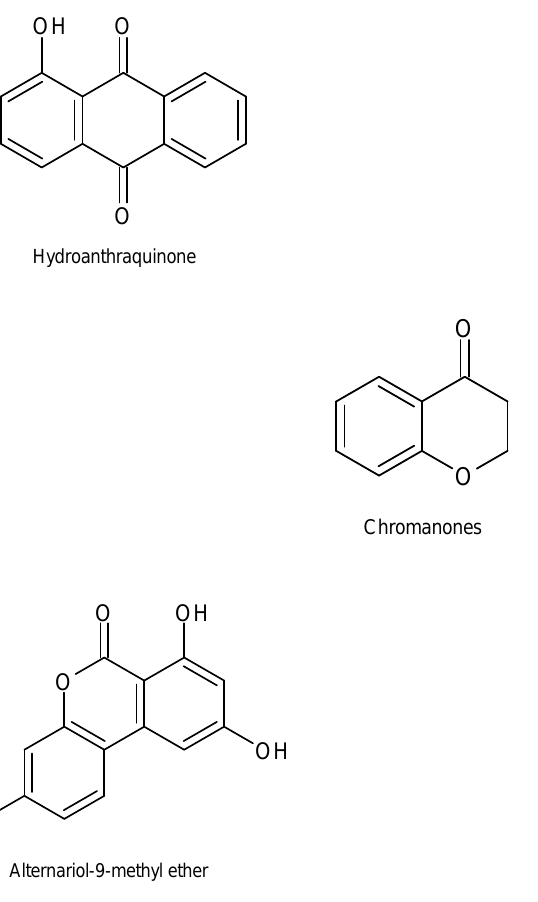
Figure 8. Chemical structures of the bioactive compounds with antiviral activities [12,20,25].